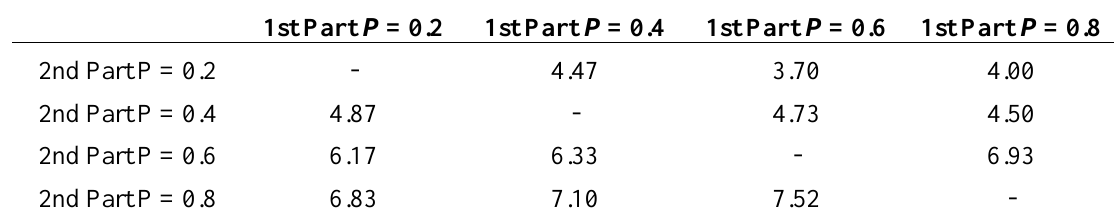
Table 3. Part 2 Average Proposer Demands for All 12 Sessions, Sorted by Current Power Treatment (Rows) and Previous Power Treatment